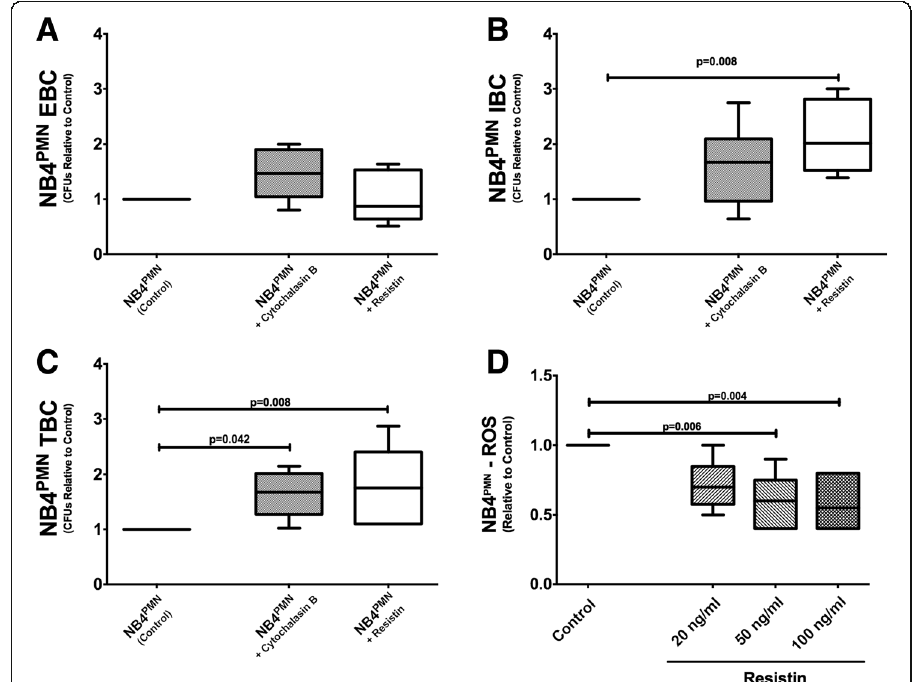
Fig. 2 Neither cytochalasin B nor resistin affects extracellular bacterial clearance by NB4 PMN cells ( a ). NB4 PMN cells exposed to resistin (100 ng/ml) exhibited lower intracellular bacterial clearance rates compared to controls but similar to that observed with cytochalasin B incubation ( b ). Total bacterial clearance was significantly impaired by both cytochalasin B and resistin (100 ng/ml) ( c ). Resistin impairs reactive oxygen species production by neutrophils in a dose-dependent manner ( d ). N = 6 for all